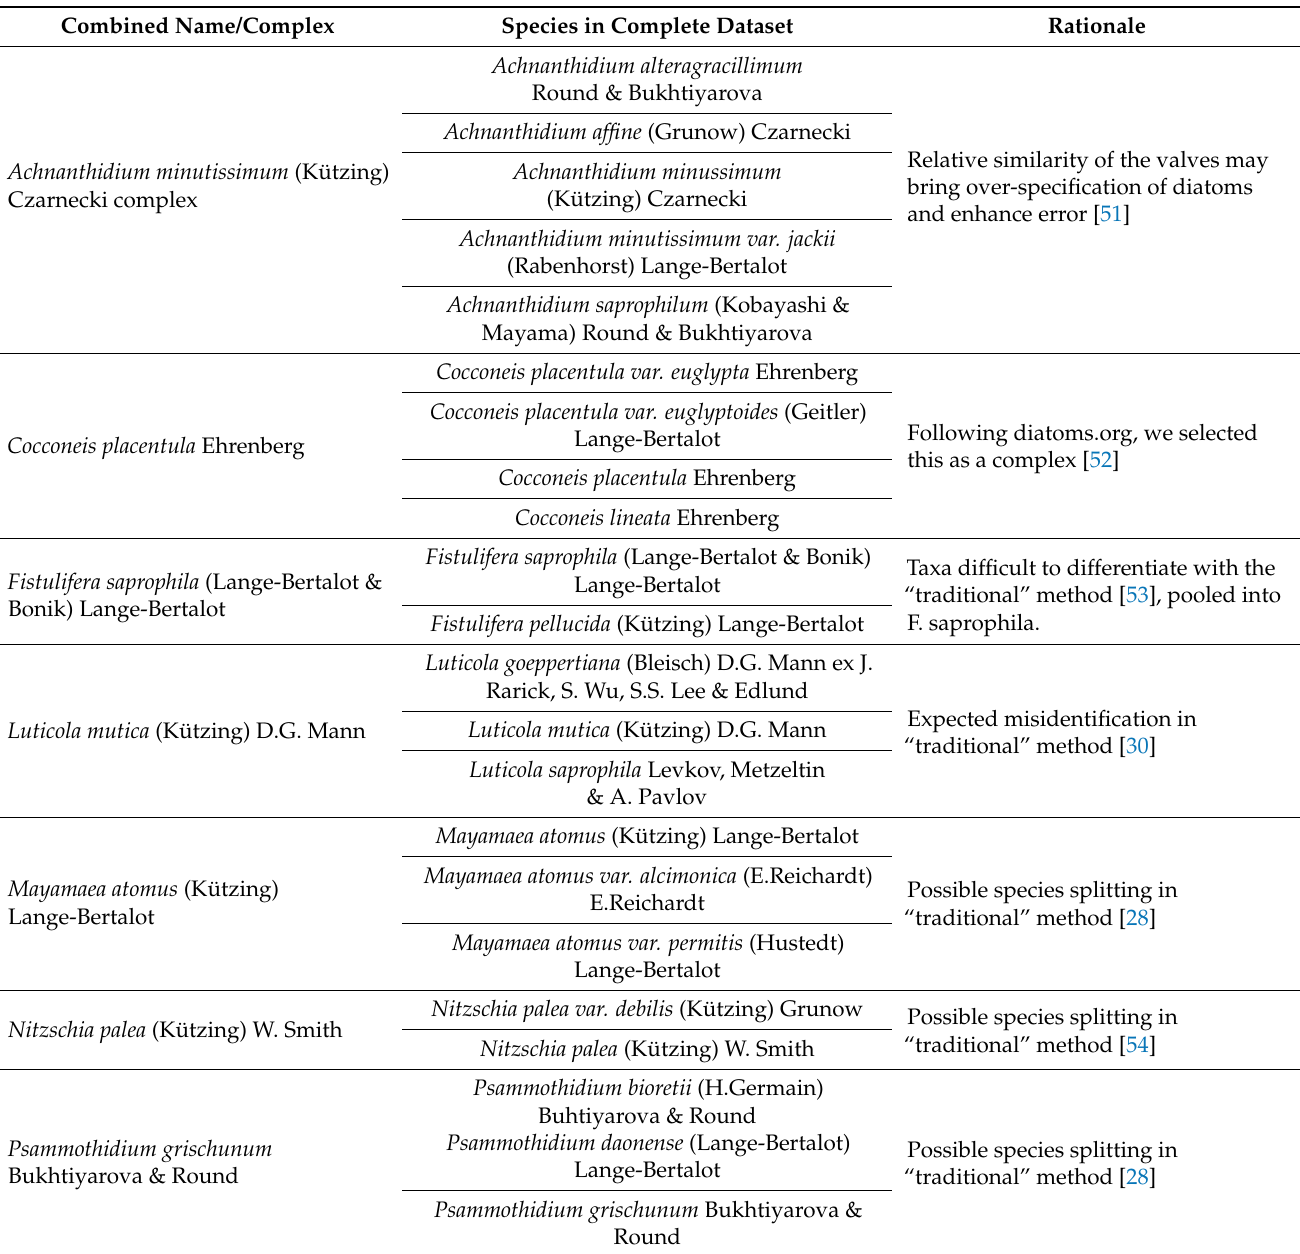
Table 1. Rationale for the reduced